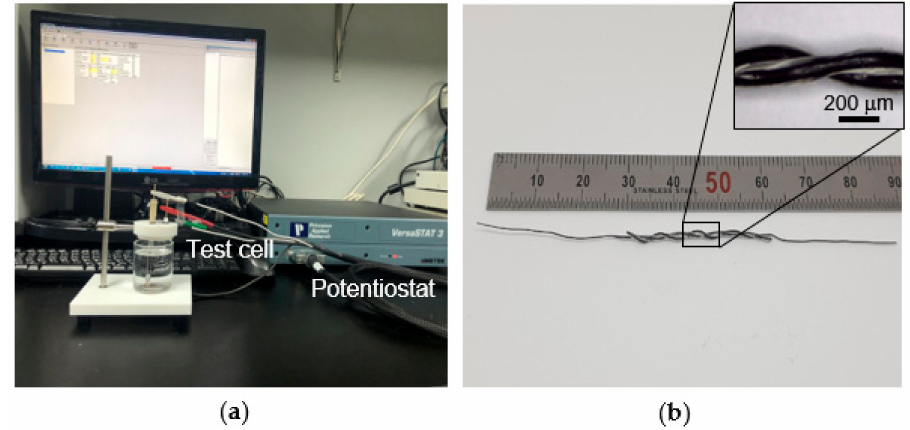
Figure 11. ( a ) Experiment set up with potentiostat and ( b ) photograph of fabricated fiber-shaped supercapacitor. Inset shows the magnified view.